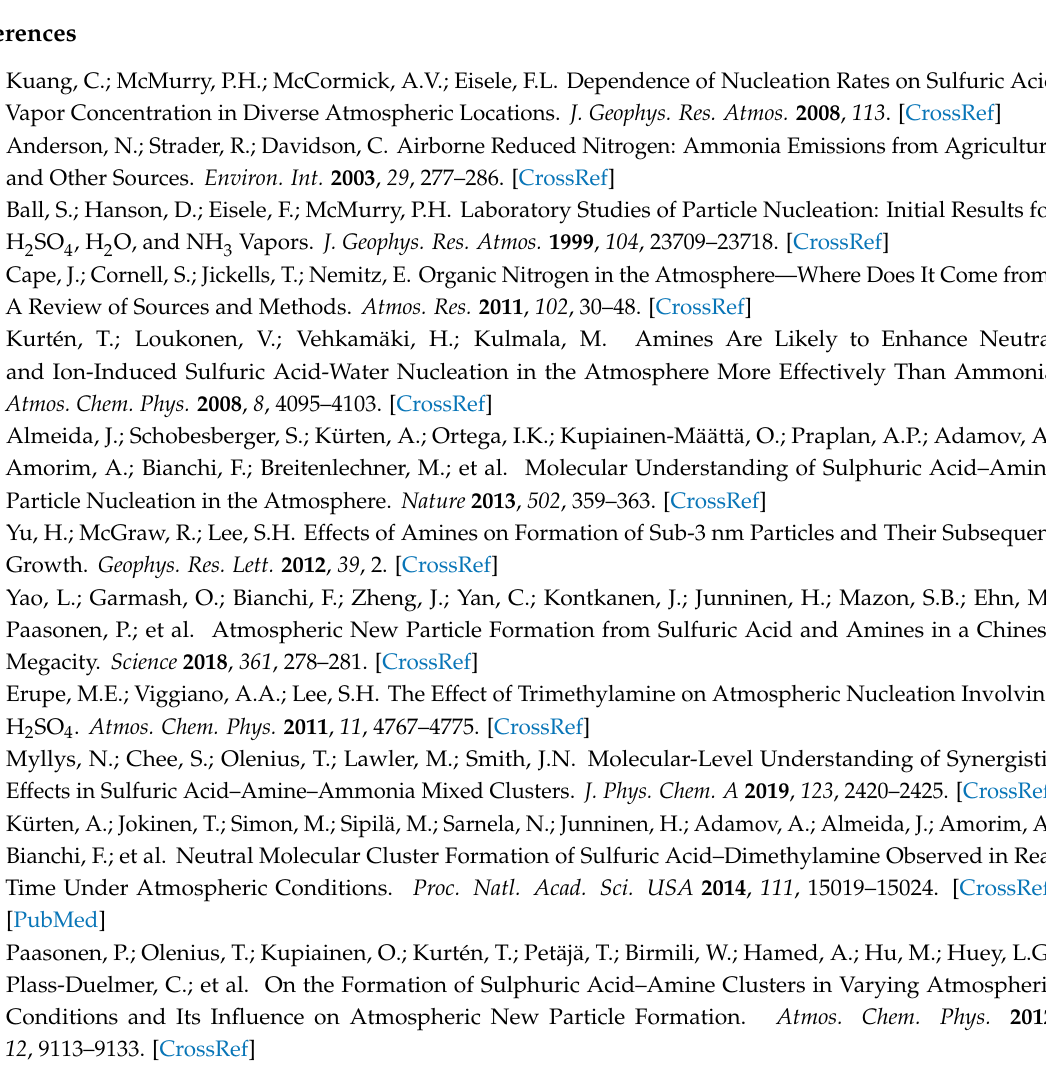
Table S1: Binding enthalpies, entropies and Gibbs free energies for all clusters; Figure S1: Main cluster growth routes of SA–GUA and SA–DMA clusters; Figure S2: Vapor concentration-dependent Gibbs free energies of SA–GUA and SA–DMA clusters; Figure S3: Steady-state cluster distributions of SA–GUA and SA–DMA clusters; zip: TMAO-containing cluster structures in xyz